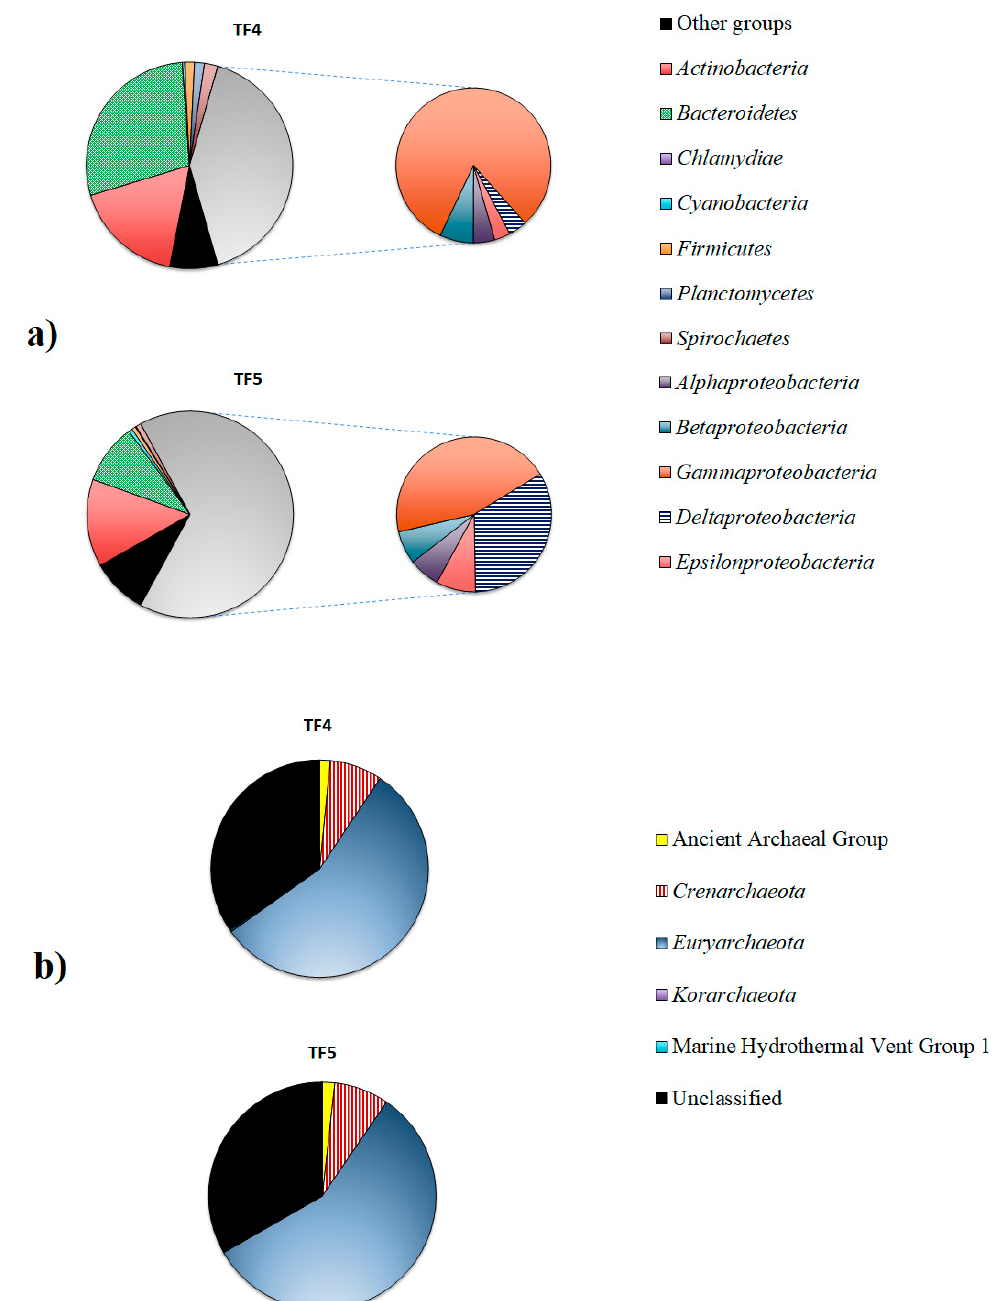
Figure 4. Bacterial ( a ) and archaeal ( b ) communities in TF4 and TF5 brines. Figure 4. Bacterial( a ) and archaeal( b ) communities in TF4 and TF5 brines. Of the total high-quality bacterial sequences obtained from TF4 and TF5, about 14% and 18%, respectively, were not classified at the genus level. A total of 268 and 269 genera from TF4 (from 0.01% to 18.3% of total sequences) and TF5 (from 0.01% to 10.9%), respectively, were resolved from the rest. Only genera occurring at ≥ 0.1% of the total bacterial sequences, resulting in 53 and 41 genera from TF4 and TF5, respectively, are reported in Figure 5a and Supplementary Table